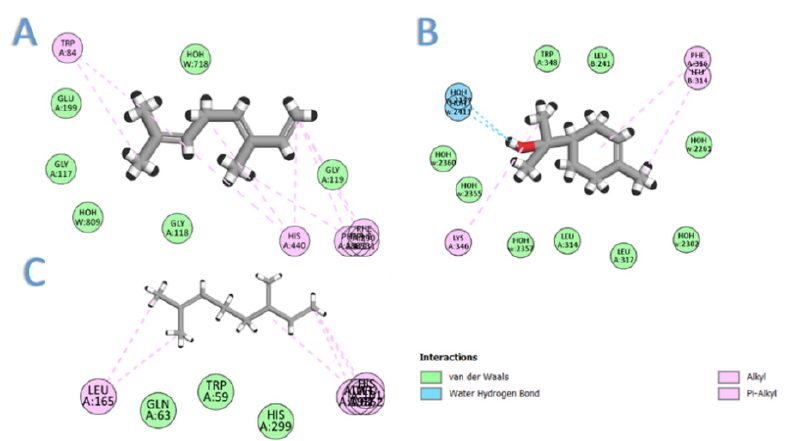
Figure 3. The 2D interaction diagram of: ( A ) β -( E )-ocimene with acetylcholinesterase; ( B ) α -terpineol with α -glucosidase; ( C ) myrcene with α -amylase. Table 2. The docking scores achieved by the major identified compounds against different enzymes.